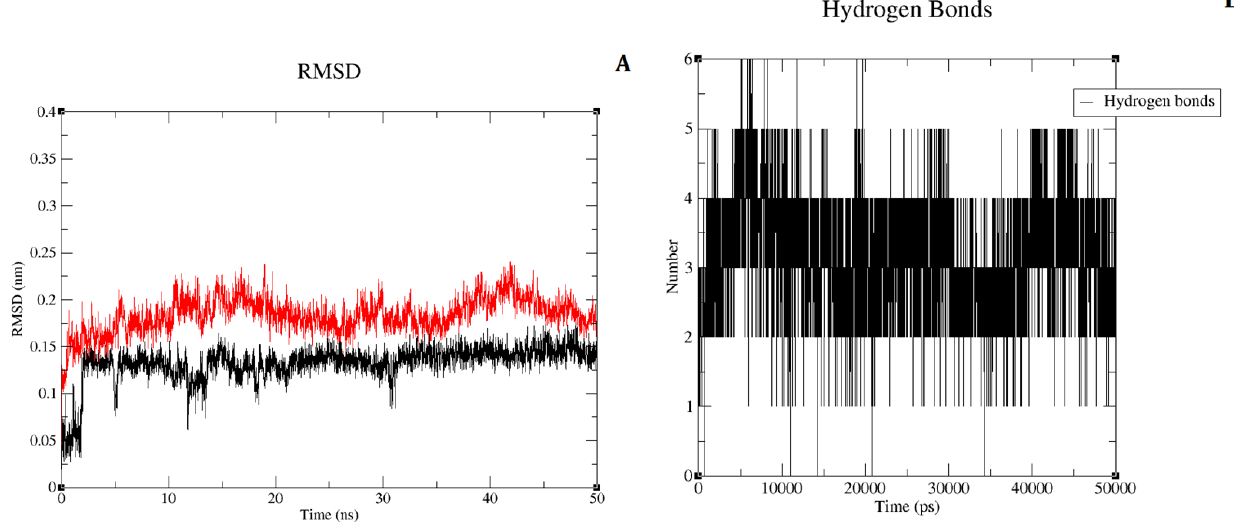
Figure 2. ( A ) Root mean square deviations (RMSDs) of the protein and compound 33, lig-and RMSD is shown in black color and protein RMSD in red color; ( B ) The graph of hydrogen bonds between compound 33 and IRAK4 throughout the 50 ns of MD.